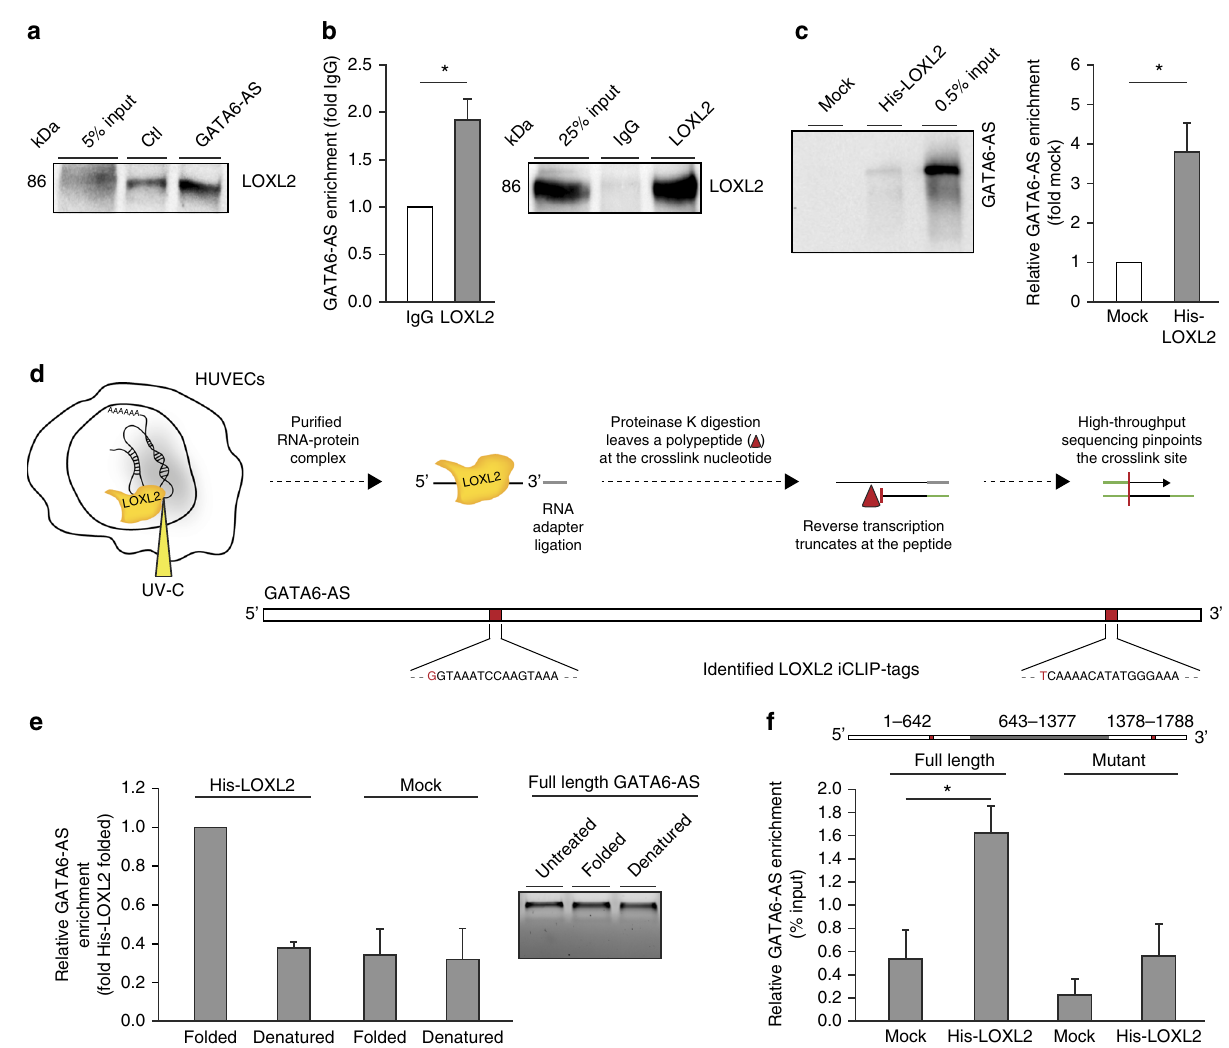
Fig. 4 GATA6-AS is directly bound by LOXL2. a Total cell lysate was prepared from HeLa cells and 5% was taken as input. The remaining lysate was distributed between GATA6-AS or scramble control antisense af fi nity selections and co-puri fi ed proteins were assayed for LOXL2 by western blotting ( n = 3; a representative image is shown). b HUVEC cell lysate was used for RNA immunoprecipitation using LOXL2 antibodies or isotype controls. Left: Co- puri fi ed RNA from LOXL2 and IgG IPs was assayed for GATA6-AS enrichment by RT-qPCR ( n = 5; SEM; * t test p < 0.05). Right: IP speci fi city was controlled by LOXL2 western blotting (a representative image is shown). c In vitro transcribed full length GATA6-AS (1788nt) was used in His-LOXL2 pulldown assays. As control, mock pulldowns were performed without protein. Left: Co-puri fi ed GATAT6-AS was visualized by Northern blotting (a representative image is shown). Right: For quanti fi cation, intensities were determined by densitometry ( n = 4; SEM; * t test p < 0.05). d Schematic outline of the LOXL2 iCLIP procedure in HUVECs (top) and identi fi ed LOXL2-binding sites within GATA6-AS (bottom). The crosslinked nucleotides of the LOXL2 iCLIP-tags are highlighted in red. e Full length GATA6-AS (1788nt) was in vitro transcribed and folded (5 min 65 °C → 10 min RT → 30 min 30 °C → 15 min 37 °C) or denatured (2 min 95 °C → ice) and used for His-tag pulldown using recombinant LOXL2. As controls, mock reactions were performed without protein. Left: Co-puri fi ed RNA was recovered and used for RT-qPCR ( n = 4; SEM). Right: Integrity of GATA6-AS input after folding or denaturation was assayed by agarose gel electrophoresis (a representative image is shown). f Full length GATA6-AS and a 735nt truncated construct (nucleotides 643 – 1377) lacking both LOXL2 interaction sites were in vitro transcribed, folded, and used for His-LOXL2 pulldown. As controls, mock reactions were performed without protein. Co-puri fi ed RNA was recovered and used for RT-qPCR ( n = 4; SEM; * t test p <